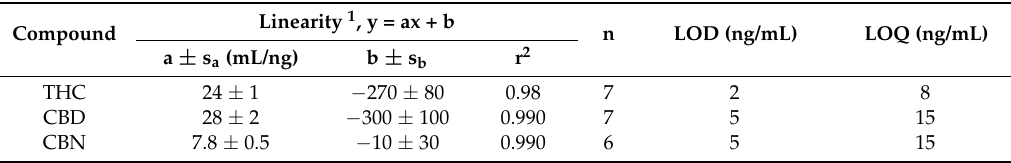
Table 1. Quantitative performance of the proposed method (values established from aqueous standard solutions of the target compounds processed by in-tube solid-phase microextraction coupled on-line to liquid chromatography